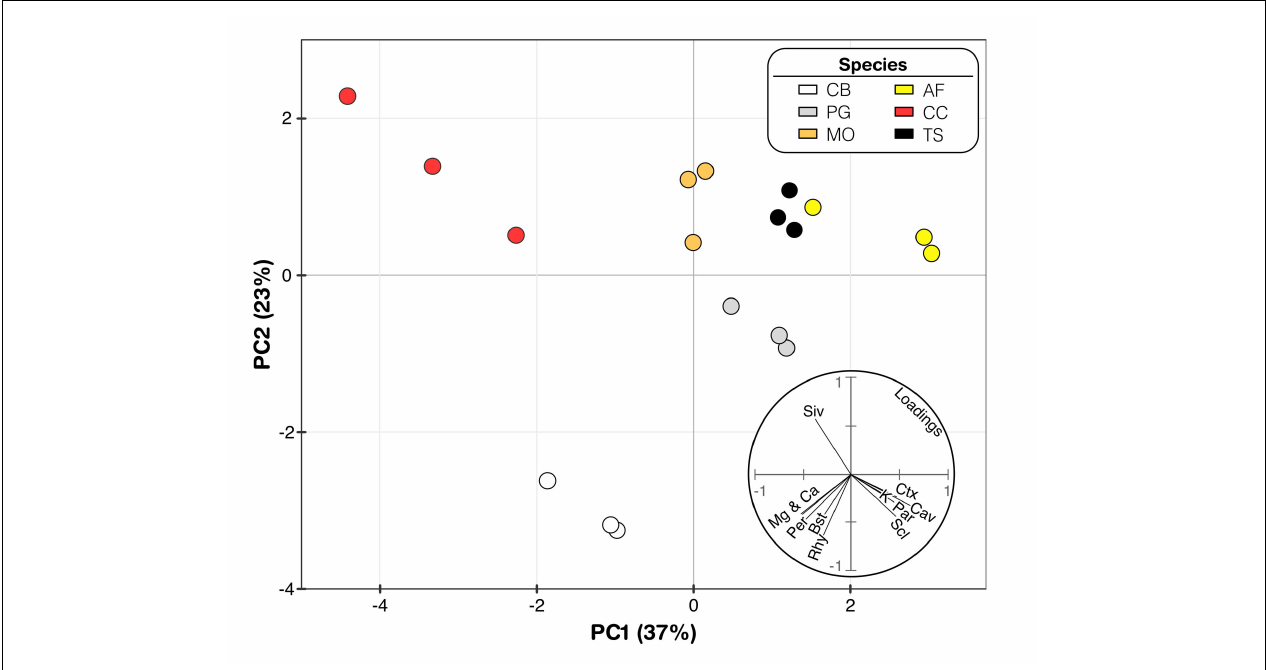
FIGURE 5 | Principal component analysis with Mg 2 + , Ca 2 + , and K + concentrations related to anatomical components. The arrows represent variable plotted by the first two PCA axes. Species abbreviations are Clethra barbinervis (CB) Padus grayana (PG) , Magnolia obovata (MO), Castanea crenata (CC), Abies firma (AF), and Tsuga sieboldii (TS),